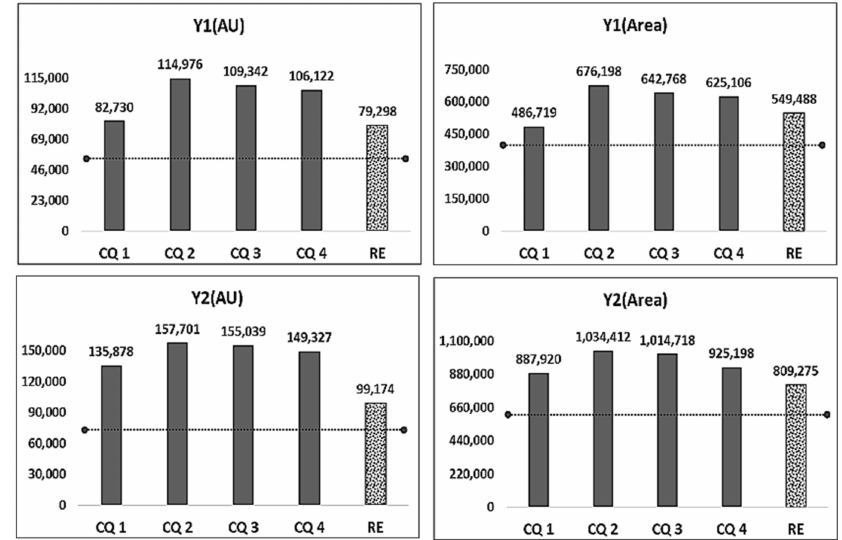
Figure 9. Comparison of experimental results in terms of mean.